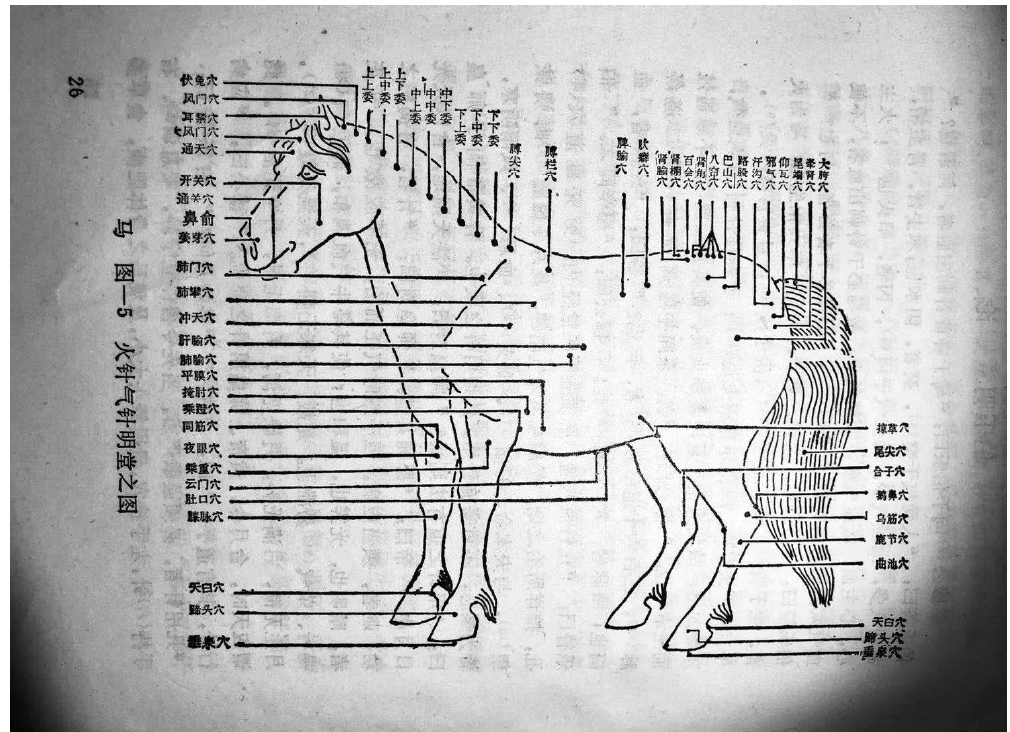
Figure 2. Illustration of the acupoints in Bo Le Ming Tang Lun [15] . One of the chapters in Yuan Heng Liao Ma Ji , Bo Le Ming Tang Lun was devoted to the application of acupuncture in the treatment of equine diseases .